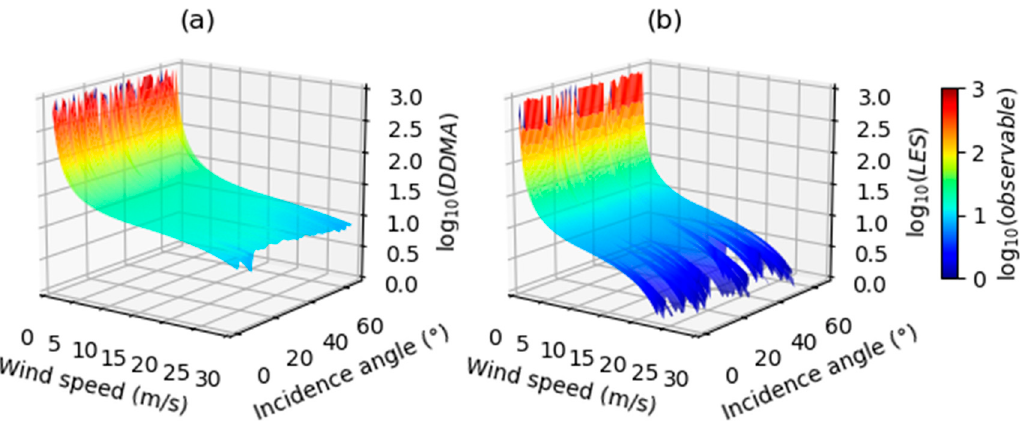
Figure 5. Delay-Doppler Map Average ( a ) and Leading Edge Slope ( b ) geophysical model function using Numerical Weather Prediction winds as the ground truth wind speed.